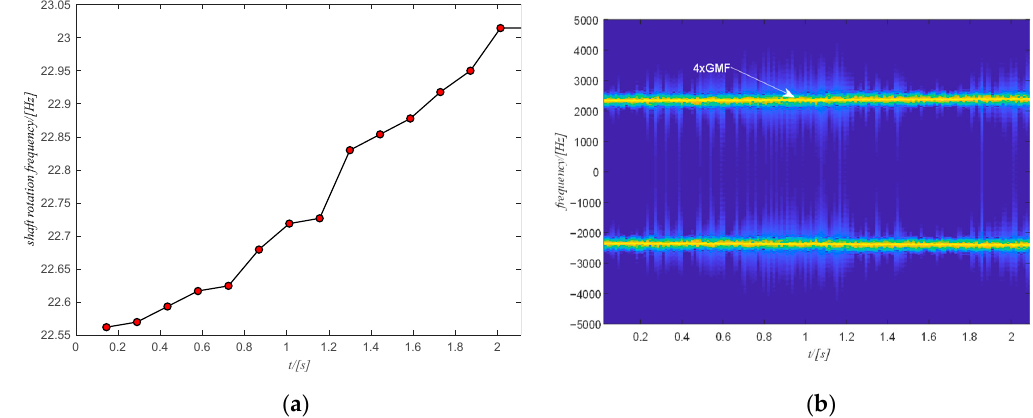
Figure 21. ( a ) The shaft rotation speed of case study 1; ( b ) the filtered spectrum of the selected Figure21. ( a )Theshaftrotationspeedofcasestudy1; ( b )thefilteredspectrumoftheselectedcomponent. component.